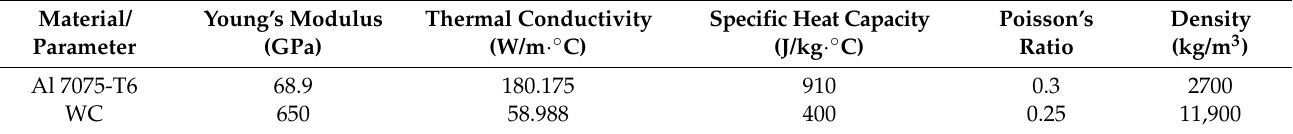
Table 2. Mechanical and thermo-physical properties of materials considered in finite element